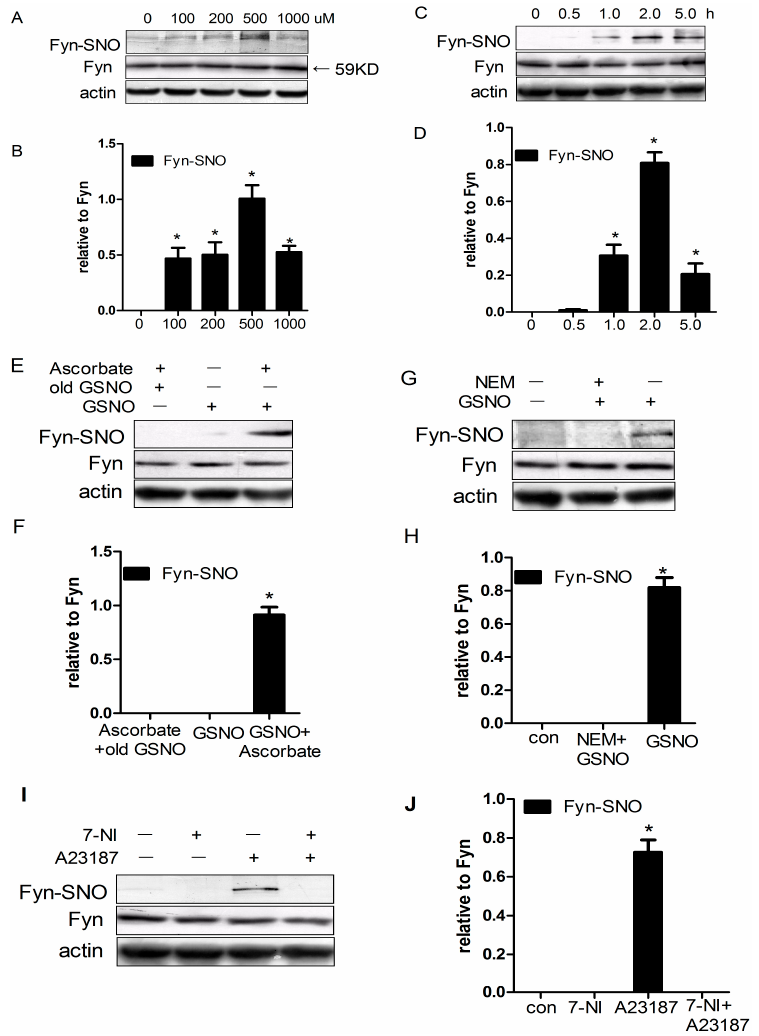
Figure 1. Fyn ( M W = 59 KD) was S -nitrosylated by S -nitrosoglutathione (GSNO) in HEK293 cells. ( A ) HEK293 cells overexpressing Fyn were treated with GSNO at 0, 100, 200, 500, and 1000 μ M for 2 h and assessed for Fyn S -nitrosylation; ( B ) Data are expressed as the means ± S.D. ( n = 4). * p < 0.05 compared with the basal level; ( C ) HEK293 cells overexpressing Fyn were treated with 500 μ M GSNO for 0, 0.5, 1, 2, and 5 h and evaluated for time-dependent patterns of Fyn S -nitrosylation by GSNO; ( D ) Data are presented as the means ± S.D. ( n = 4). * p < 0.05 compared with the basal level; ( E ) After serum starvation for 2 h, HEK293 cells overexpressing Fyn were treated with either 500 μ M inactive GSNO or 500 μ M GSNO, as indicated, for 2 h. Fyn S -nitrosylation was assessed in the absence or presence of ascorbate, as indicated; ( F ) Data are expressed as the means ± S.D. ( n = 4). * p < 0.05 compared with the ascorbate plus inactive GSNO group; ( G ) HEK293 cells overexpressing Fyn were treated with or without N -ethylmaleimide (NEM) in the absence of serum for 2 h, followed by administration of 500 μ M GSNO for 2 h; ( H ) Data are expressed as the means ± S.D. ( n = 4). * p < 0.05 compared with the control group; ( I ) HEK293 cells co-overexpressing Fyn and nNOS were deprived of serum for 2 h, then treated with the presence or absence of 7-nitroindazole (7-NI), and then treated with A23187; ( J ) Data are expressed as the means ± S.D. ( n = 4). * p < 0.05 vs. the control group.